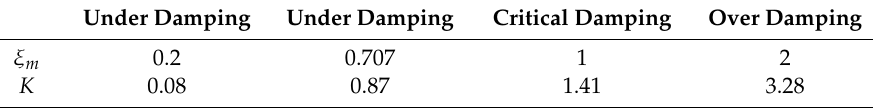
Table 2. The parameter K derived from di ff erent damping ratios ξ m . Under Damping Under Damping Critical Damping Over